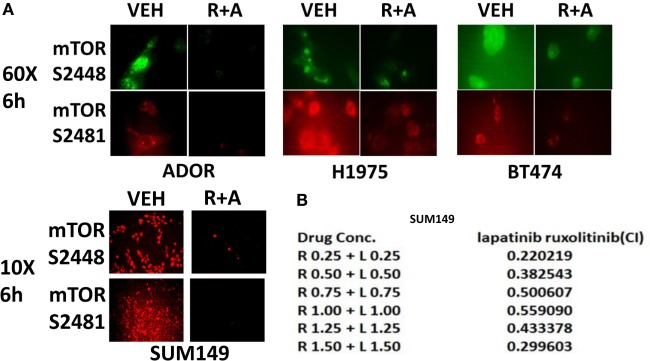
The JAK1/2 inhibitor Ruxolitinib interacts with the ERBB1/2 inhibitor afatinib to reduce the phosphorylation of mTOR at Serine 2448 and Serine 2481: inactivation of mTORC1 and mTORC2. (A) BT474, ADOR, SUM149, and H1975 cells were treated with vehicle control or [ruxolitinib (2 μM) + afatinib (2 μM)] for 6 h. After 6 h, cells were fixed in place and immuno-fluorescence was performed to detect at 60× magnification or at 10× as indicated, the phosphorylation status of mTOR S2448 and mTOR S2481. (B) Triple-negative SUM149 cells were plated (250–1,000) cells per well of a six well plate and 12 h after plating were treated with vehicle, ruxolitinib (0.25–1.5 μM; 0.5–2.5 μM), lapatinib (0.25–1.5 μM), or in combination at a constant ratio for 24 h, as indicated. The media was removed, cells were washed with drug-free media, and the cells cultured for another 10 days in drug-free media. Cell colonies were fixed, stained and groups of cells >50 were counted as colonies. The combination index (CI) for synergy was calculated using the Calcusyn for Windows program using the Cho and Tallalay Method (n = 2; 12 individual wells per data point ± SEM). A combination index of <0.70 indicates a strong level of tumor-killing synergy between the drugs.